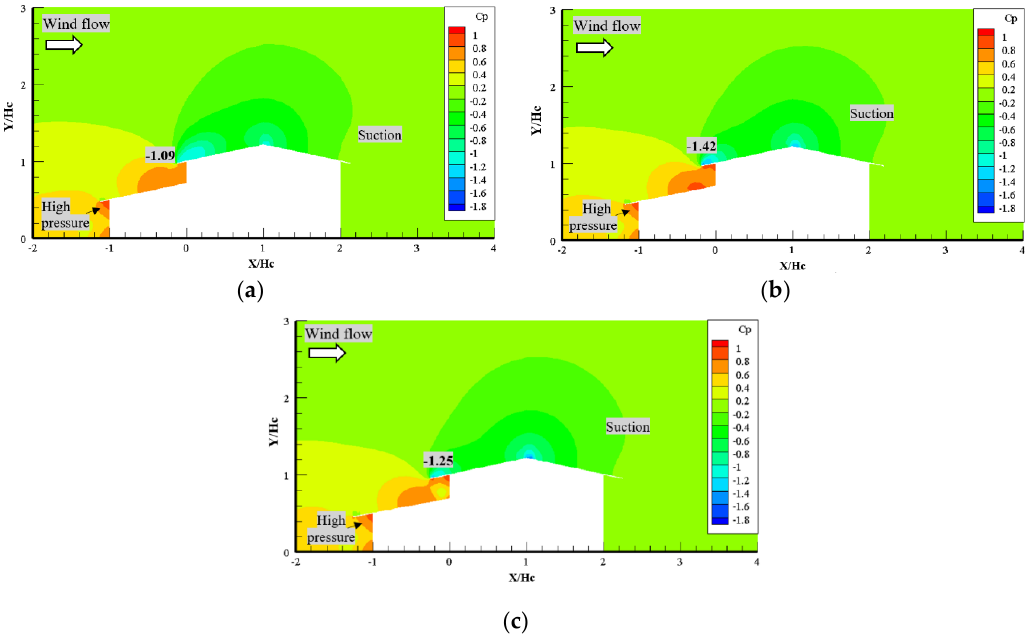
Figure 17. The pressure coefficient contours for model with kitchen at the center with a roof pitch of ( a ) 12°; ( b ) 17°; ( c ) 22°; and ( d ) 27°.